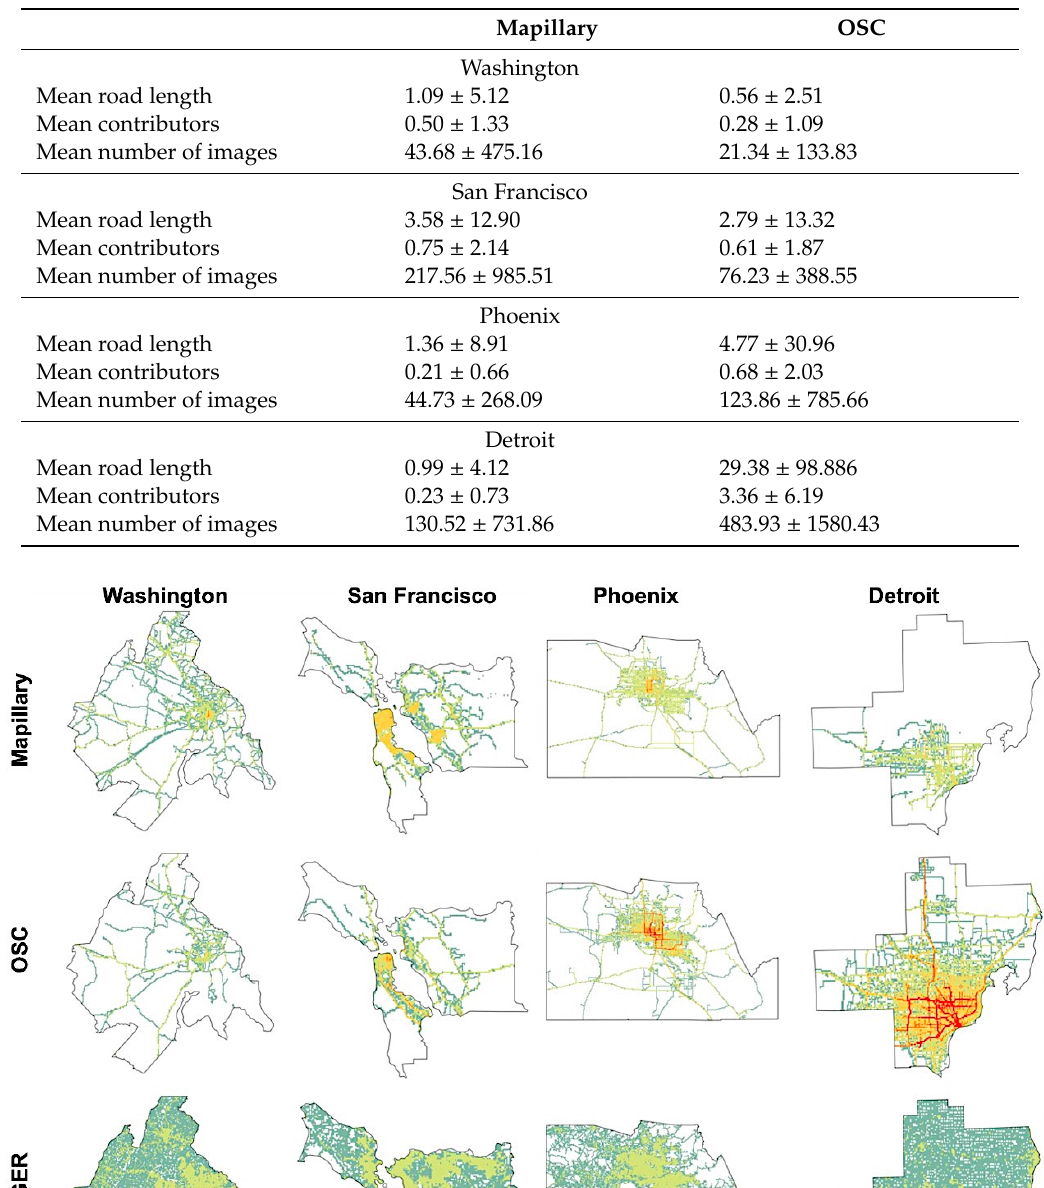
Table 3. Summary statistics (mean ± standard deviation) per 1 × 1 km grid cell area.